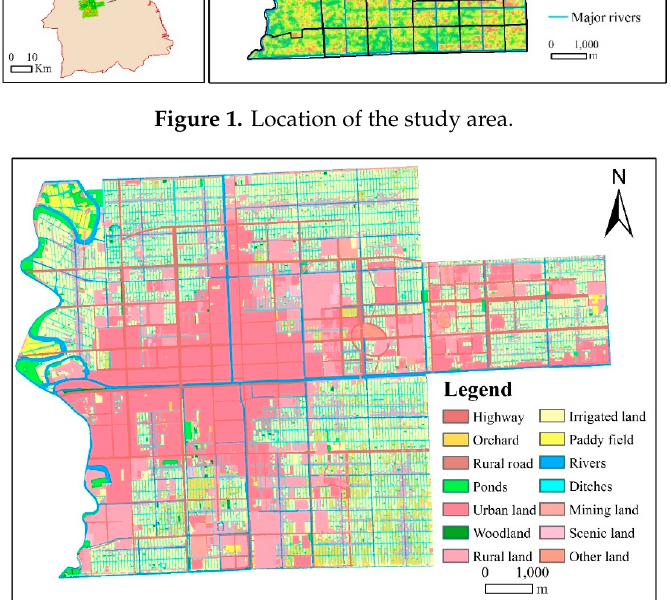
Figure 2. Land use types in the study area.